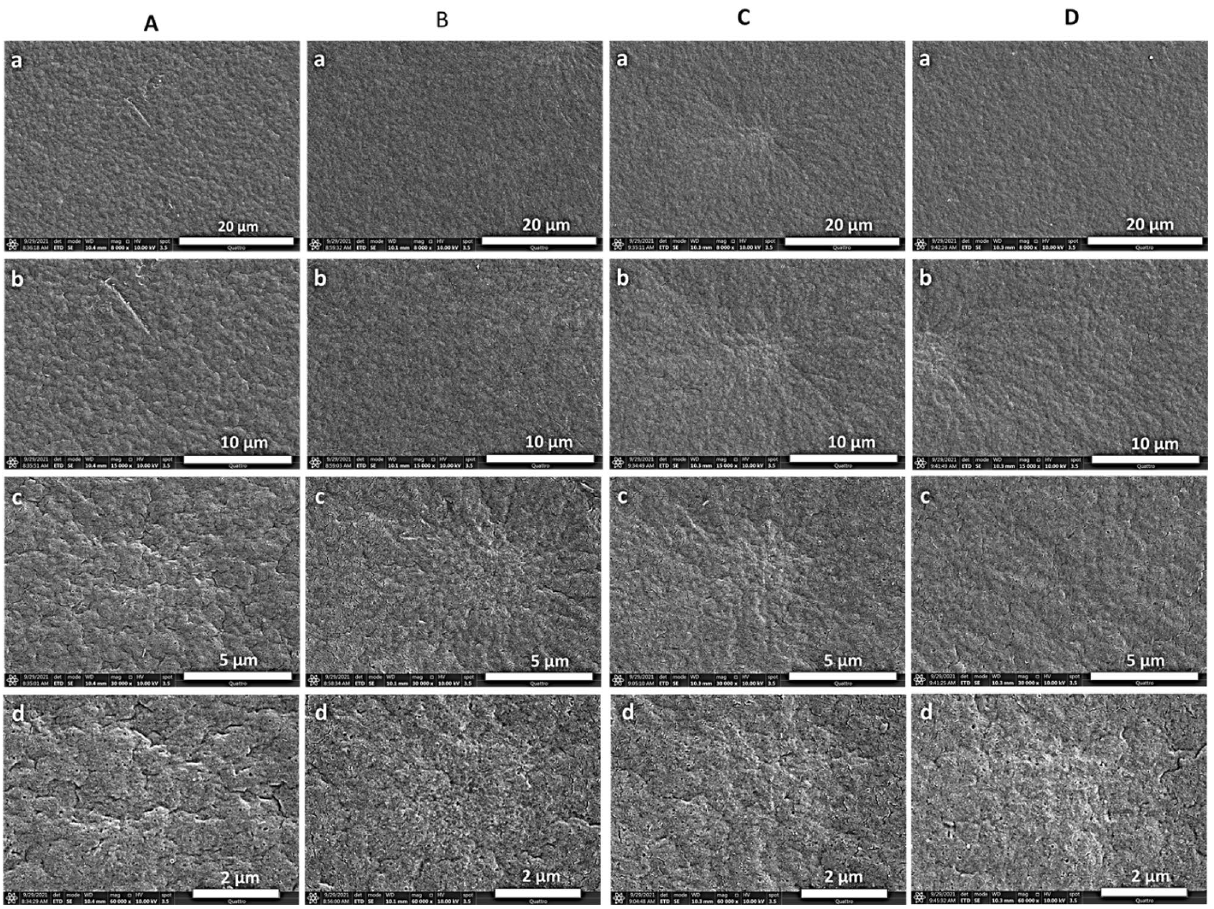
Figure 4. SEM images of the membranes ( A ) M-0, ( B ) M-1, ( C ) M-2 and ( D ) M-3 at various magnifications of ( a ) 8 Kx, ( b ) 15 Kx, ( c ) 30 Kx, and ( d ) 60